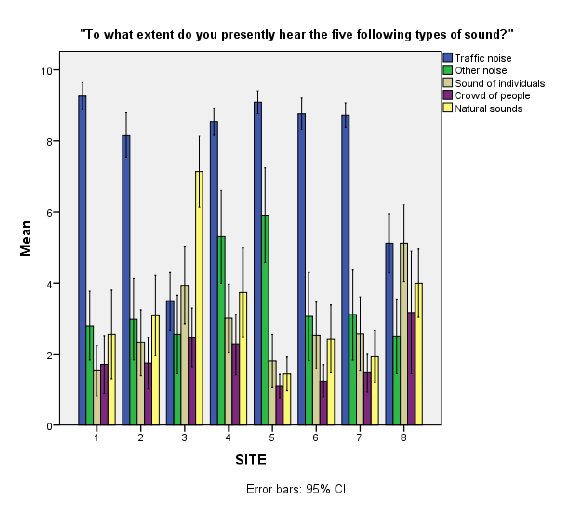
Figure 4: Mean values and 95% CI of the individual responses for Q1 Table 2: Multiple linear regression models for the eight considered variables